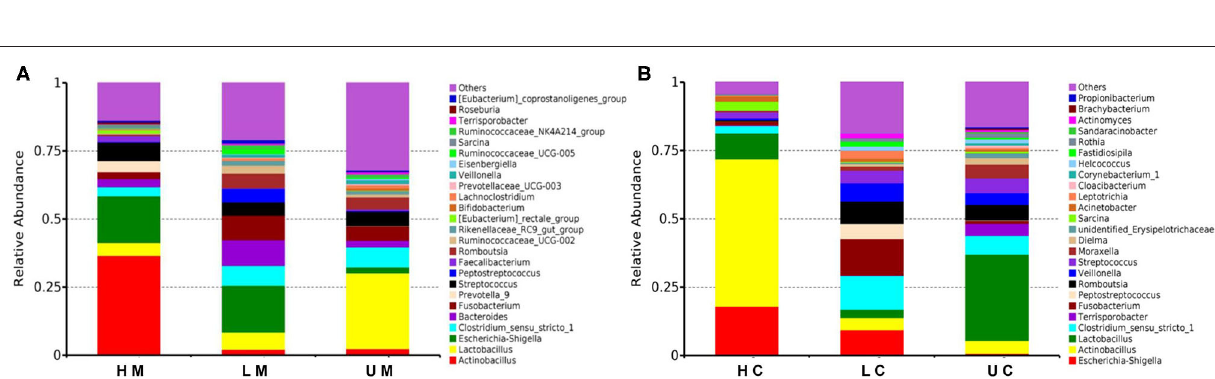
clear segregation was observed between different sample types ( Figure 1